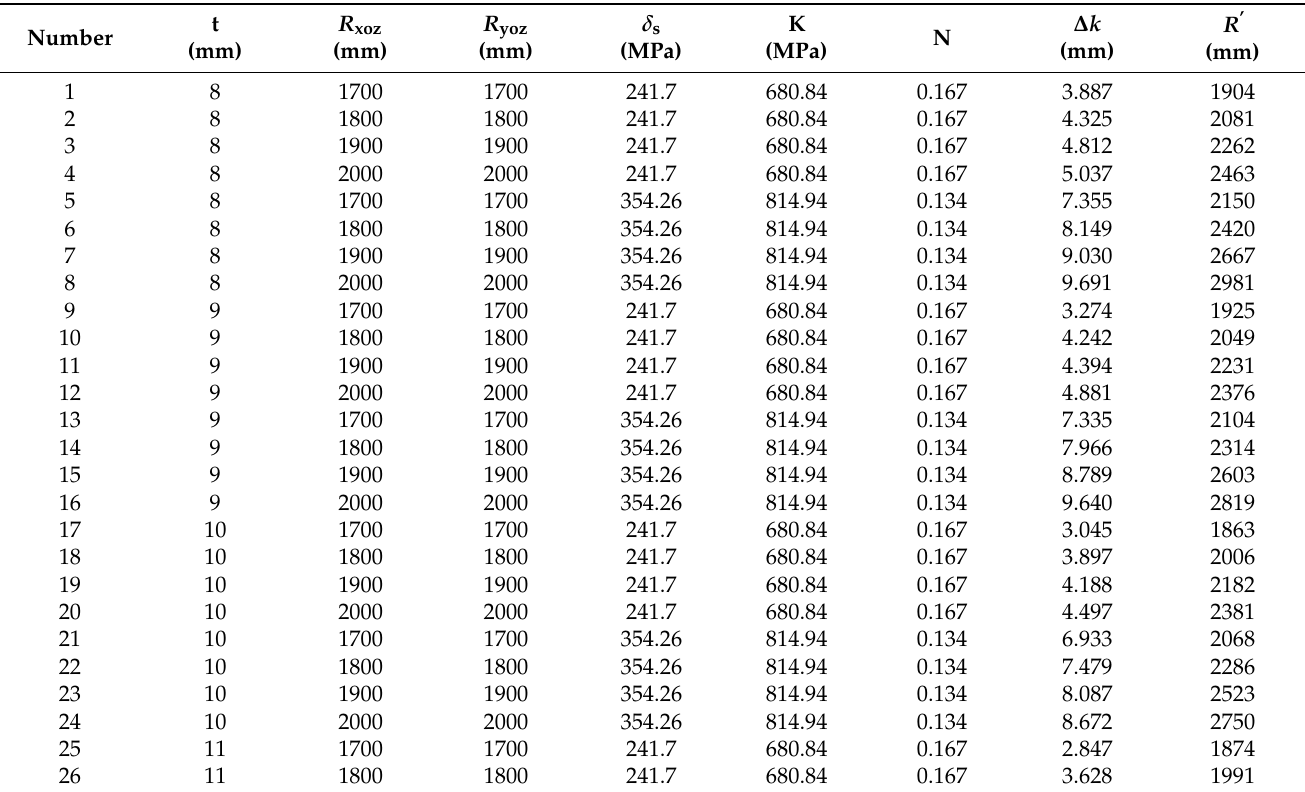
Table 4. Results of partial molding simulation data.